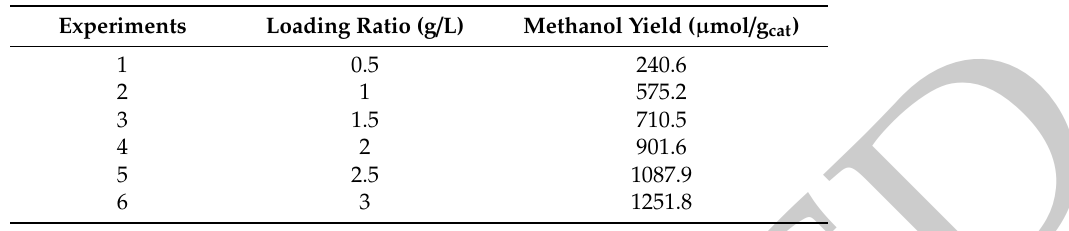
Table 3 will further clarify that at which loading ratio quantity, Methanol yield will be optimum etc. Table 3. Methanol yield with respect to loading